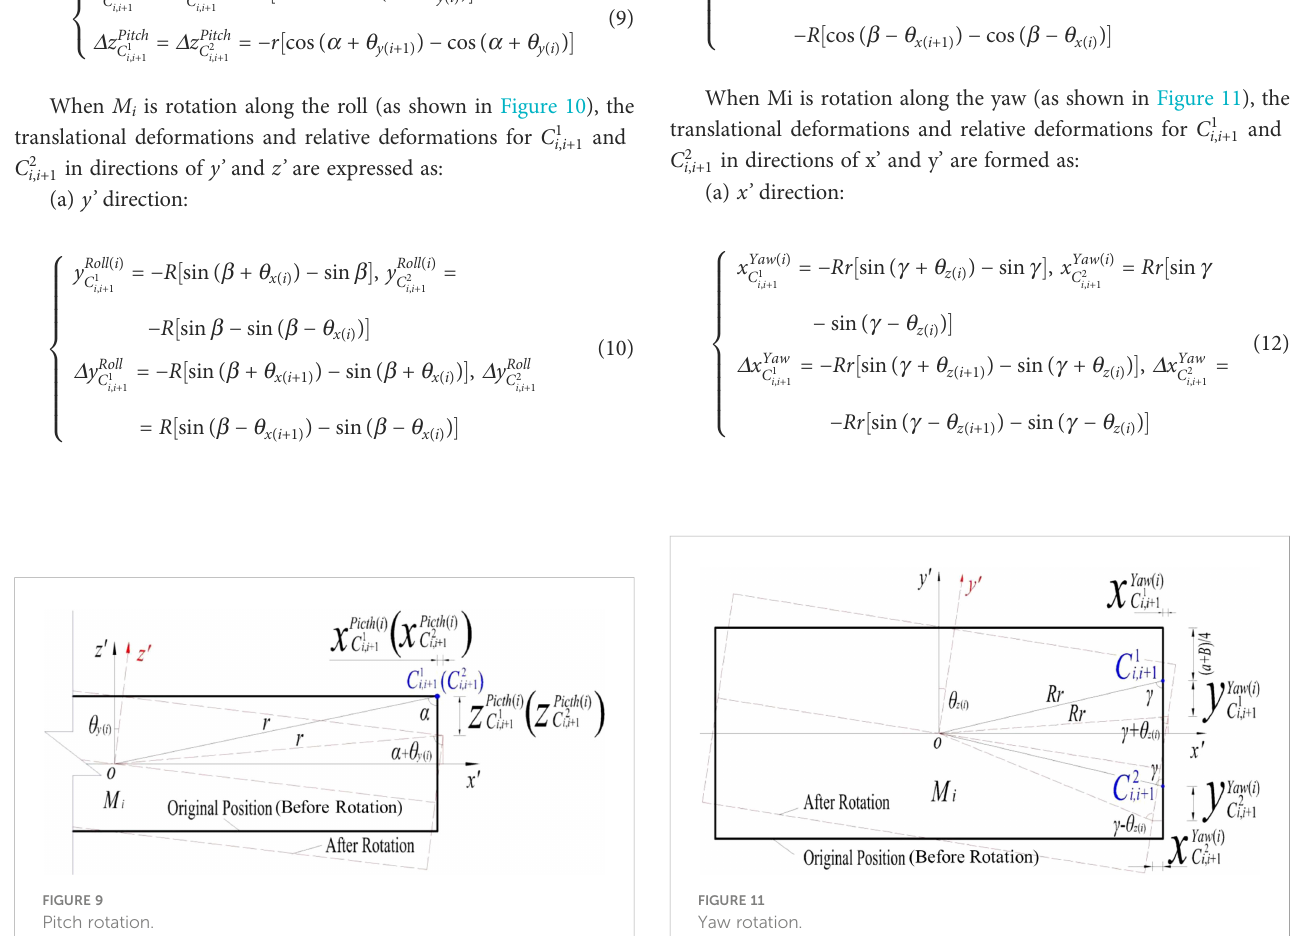
FIGURE 9 Pitch rotation.